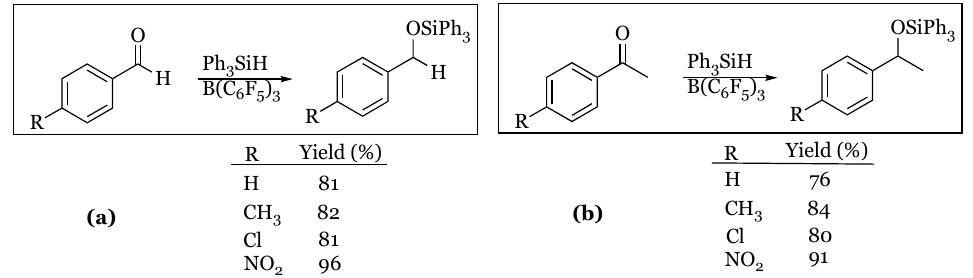
Figure 10. Reduction of: ( a ) benzaldehyde derivatives; ( b ) acetophenone derivatives.